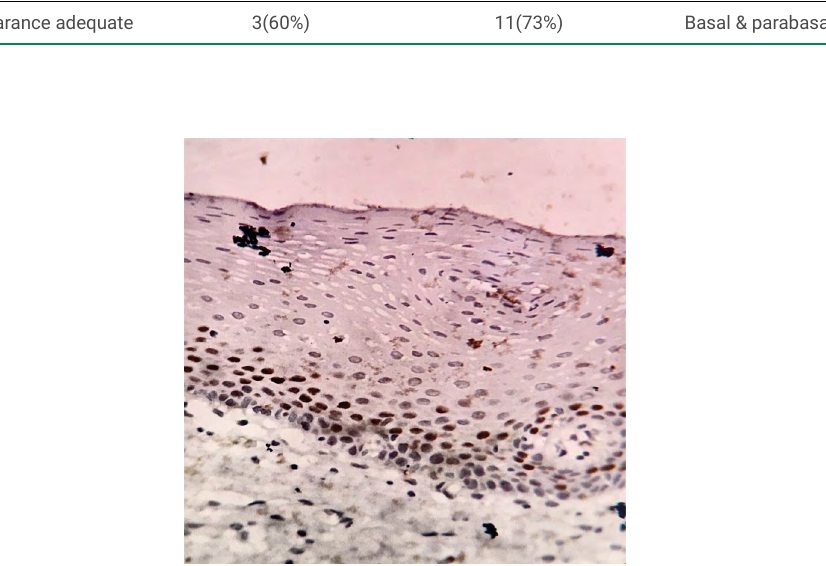
Figure 1. Positive expression of cyclin D1 in the basal and parabasal layer of resected surgical margins.